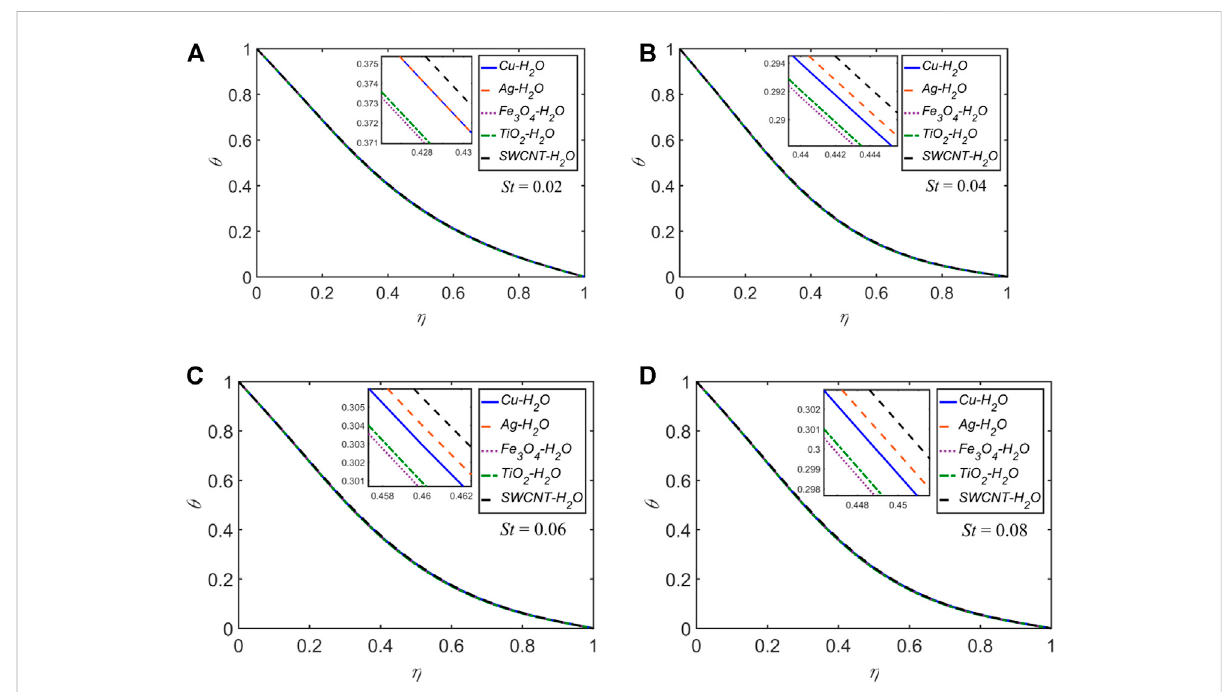
The temperature pro fi le θ versus η at x (cid:2) 0 and t (cid:2) 0 . 25 for the fi ve NFs for distinct values of St .